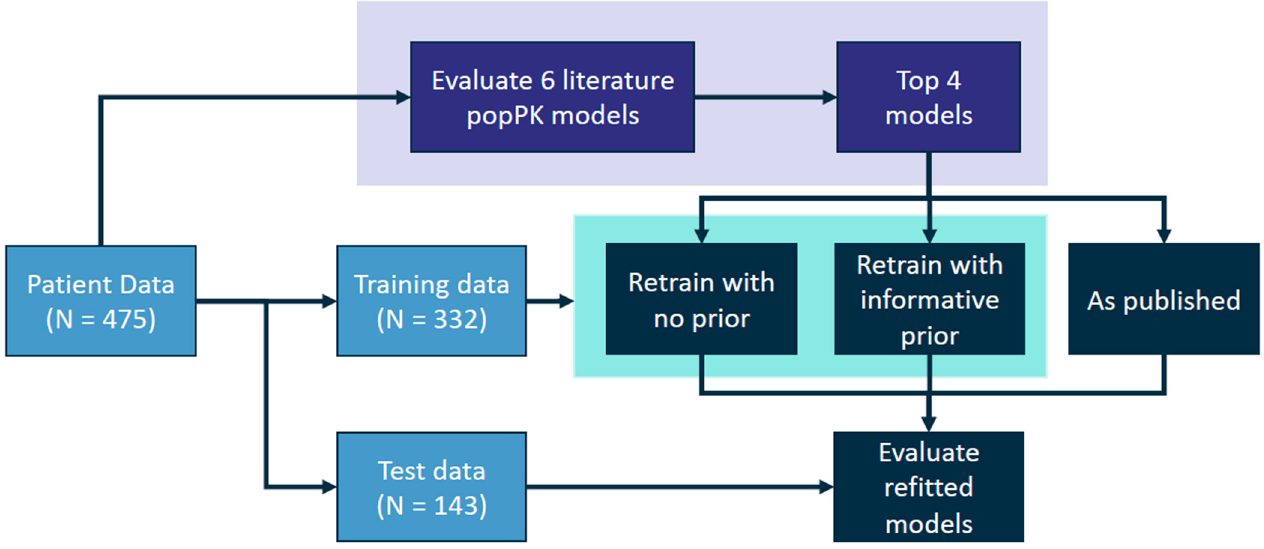
Figure 2. Diagram depicting the experimental design of this study. Six population pharmacokinet ‐ ic models from the literature were evaluated (purple box). The three models with lowest error and bias were retrained with and without priors (teal box) and evaluated on a held ‐ out test data set.